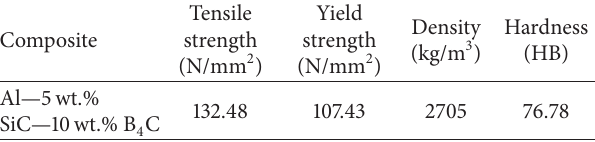
Table 1: Mechanical properties of the composite.